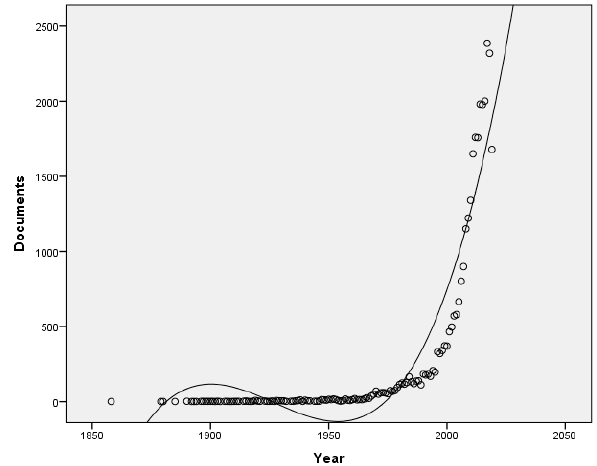
Figure 1. Annual growth of publications from 1858 to 2019 (27 August), Cubic R 2 =